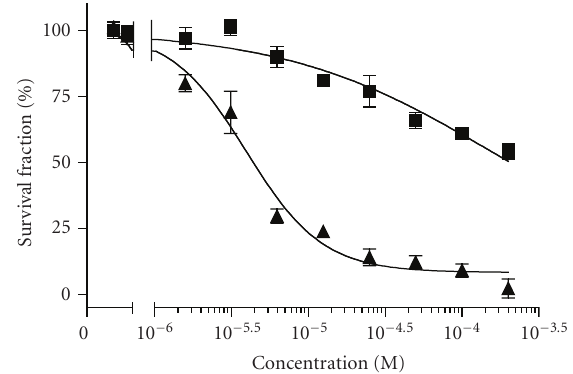
Figure 3: Cytotoxic e ff ects of [Au(II)Hp cisplatin ( (cid:3) ) against the human embryonic kidney cell line 293T as assessed by the MTT-dye reduction assay after 72 hours exposure. Each data point represents the arithmetic mean ± sd of eight separate